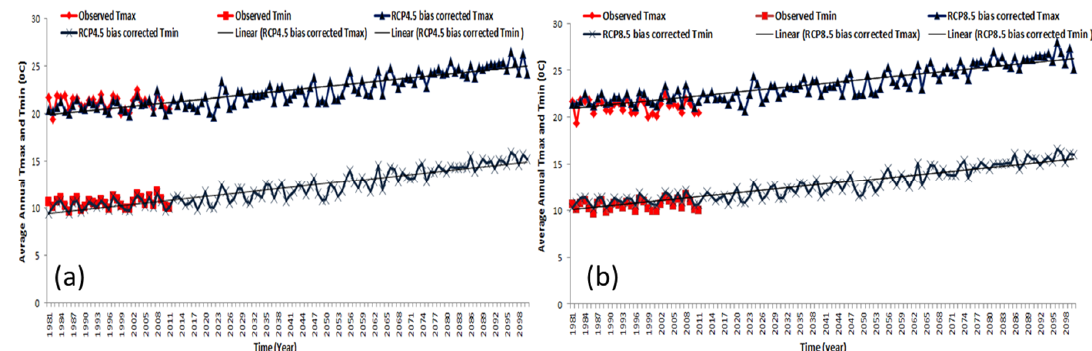
Figure 5. Future trends of ( a ) representative concentration pathways (RCP4.5) and ( b ) representative concentration pathways (RCP8.5) maximum and minimum mean annual temperatures (1981–2100).